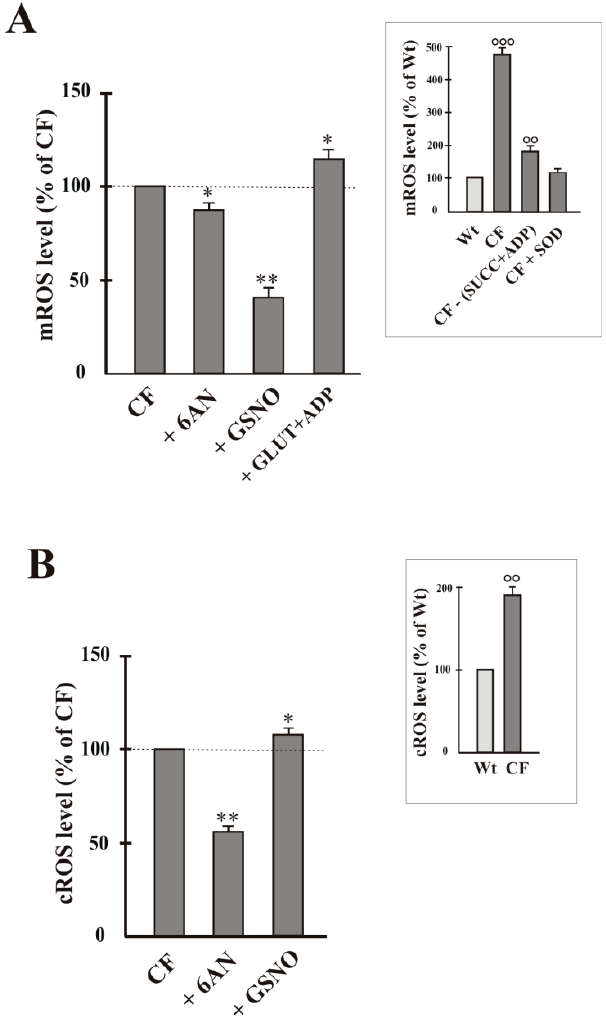
Figure 4. ROS level in airway cells. Mitochondrial and cytosolic O 2 −• production was detected